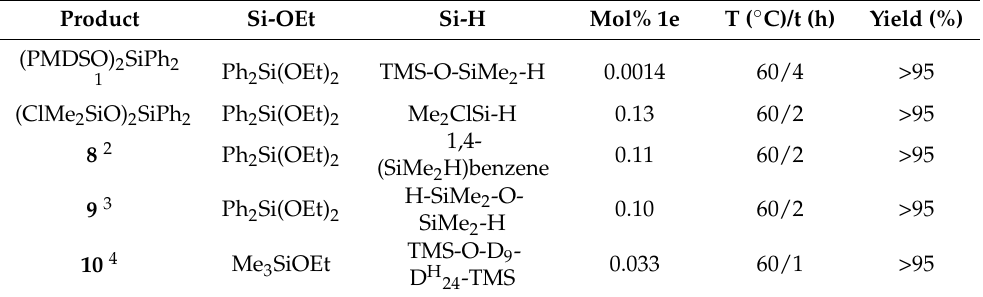
Table 4. Piers-Rubinsztajn (PR) reaction of ethoxysilanes (Si-OEt) and hydridosil(ox)anes (Si-H) catalyzed by 1h in the presence of 5–10% w / w dichloromethane as a solvent [37].